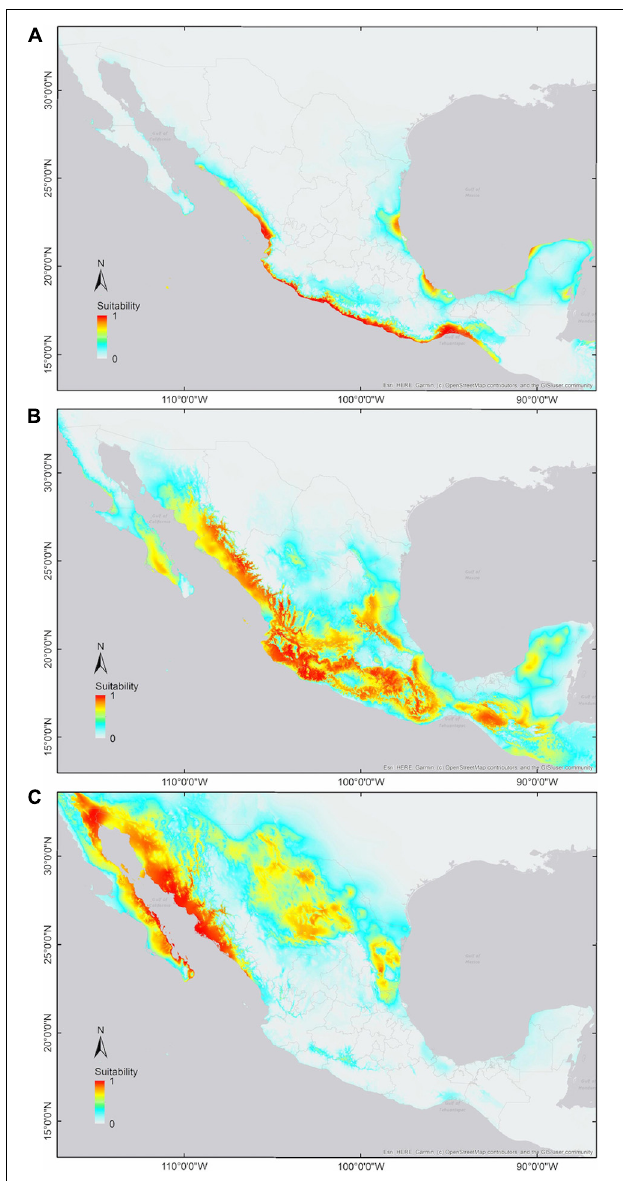
FIGURE 2 | Predicted environmental suitability (continuous output) for members of G. hirsutum wild-to-domesticated complex. (A) Wild cotton; (B) feral cotton; and (C) domesticated cotton. Color range: High suitability (red-orange), medium suitability (yellow-pale green), low suitability (turquoise), and no suitability (no